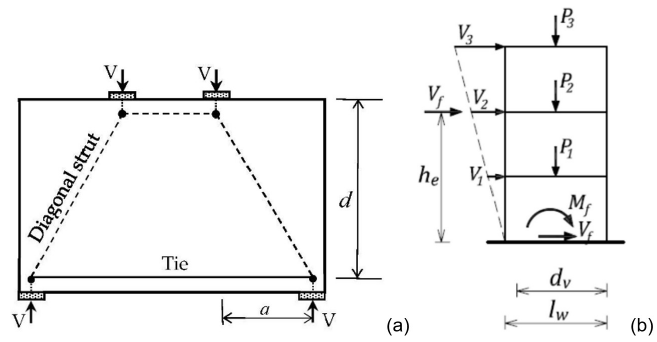
Figure 5. Shear span to depth ratio of: (a) a beam [45]; (b) a wall